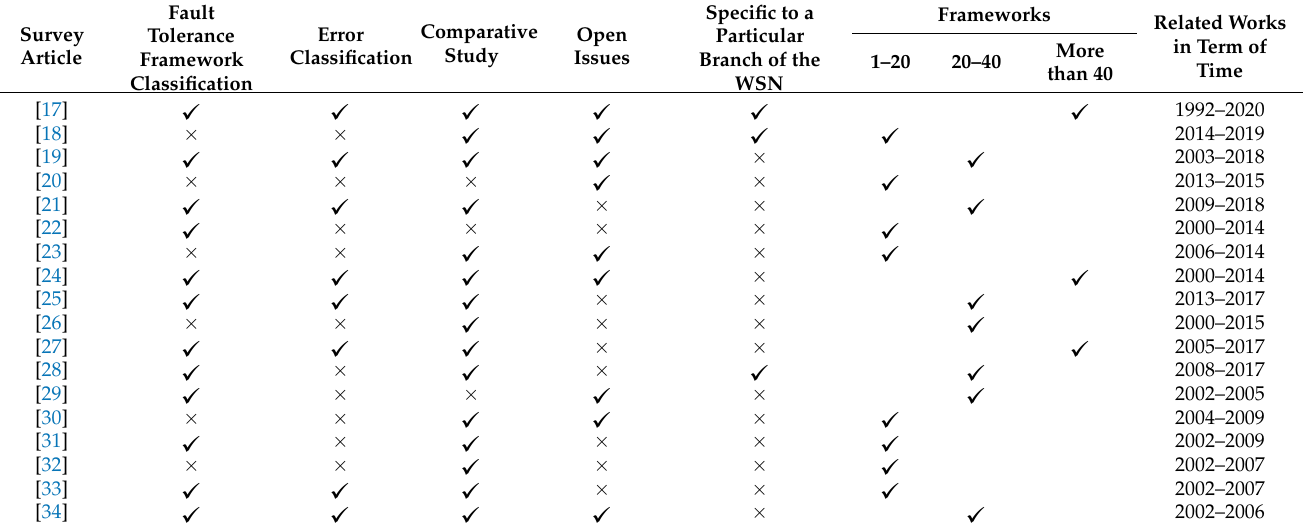
Table 1. Surveys on Fault-Tolerant in WSNs.